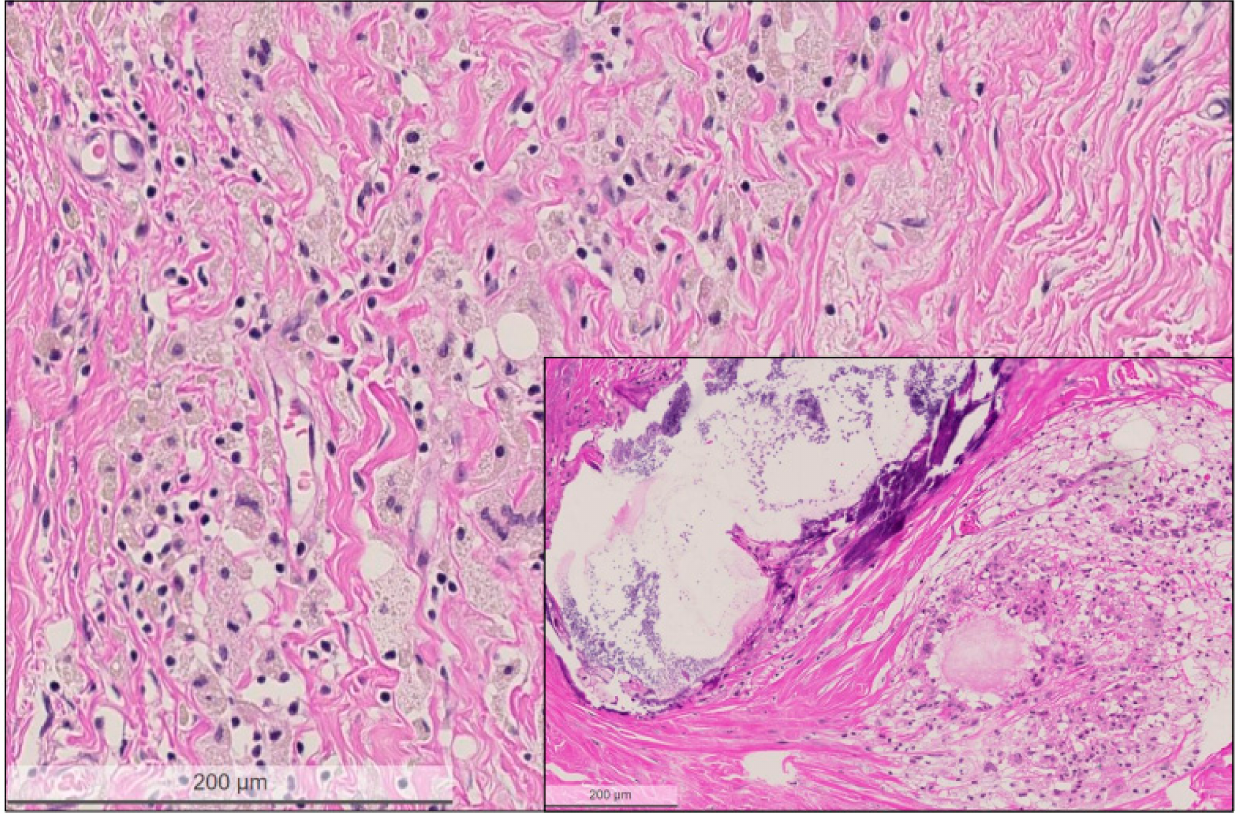
Figure 4. High power view of the regressive tumor bed devoid of residual carcinoma cells. The tumor bed area is characterized by loose collagenous stroma, macrophages lacking pre-existing tubulo- lobular units or invasive carcinoma. Inset shows another tumor bed area with large calcification and cystic macrophage reaction. Hematoxylin and eosin (H&E) stain, bar: 200